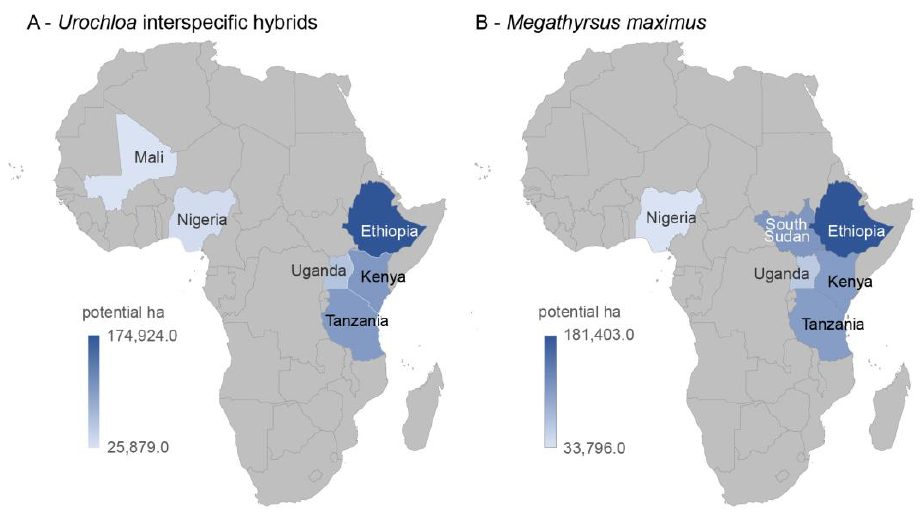
Figure 3. Market size for new interspecific Urochloa ( A ) and Megathyrsus maximus ( B ) hybrids. Sources: [85] and (V. Castiblanco and A. Notenbaert personal communication, 13 June 2019).